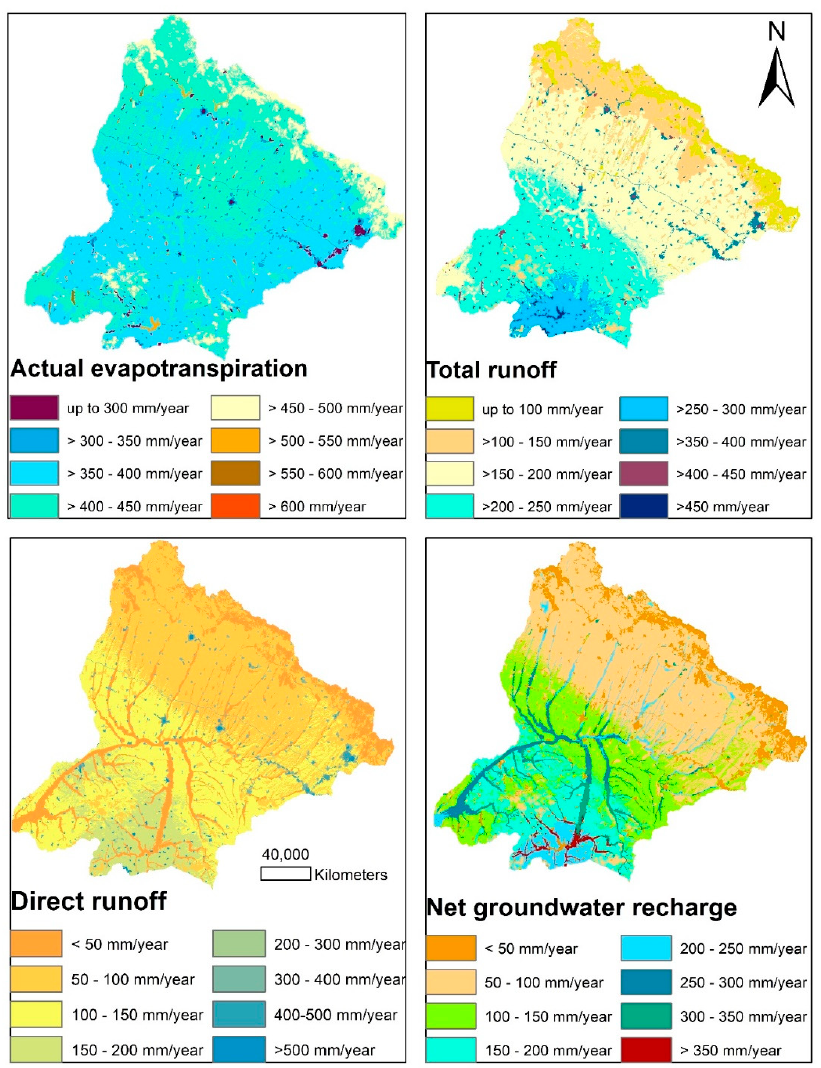
Figure 6. mGROWA simulated water budget quantities in the Ergene catchment.